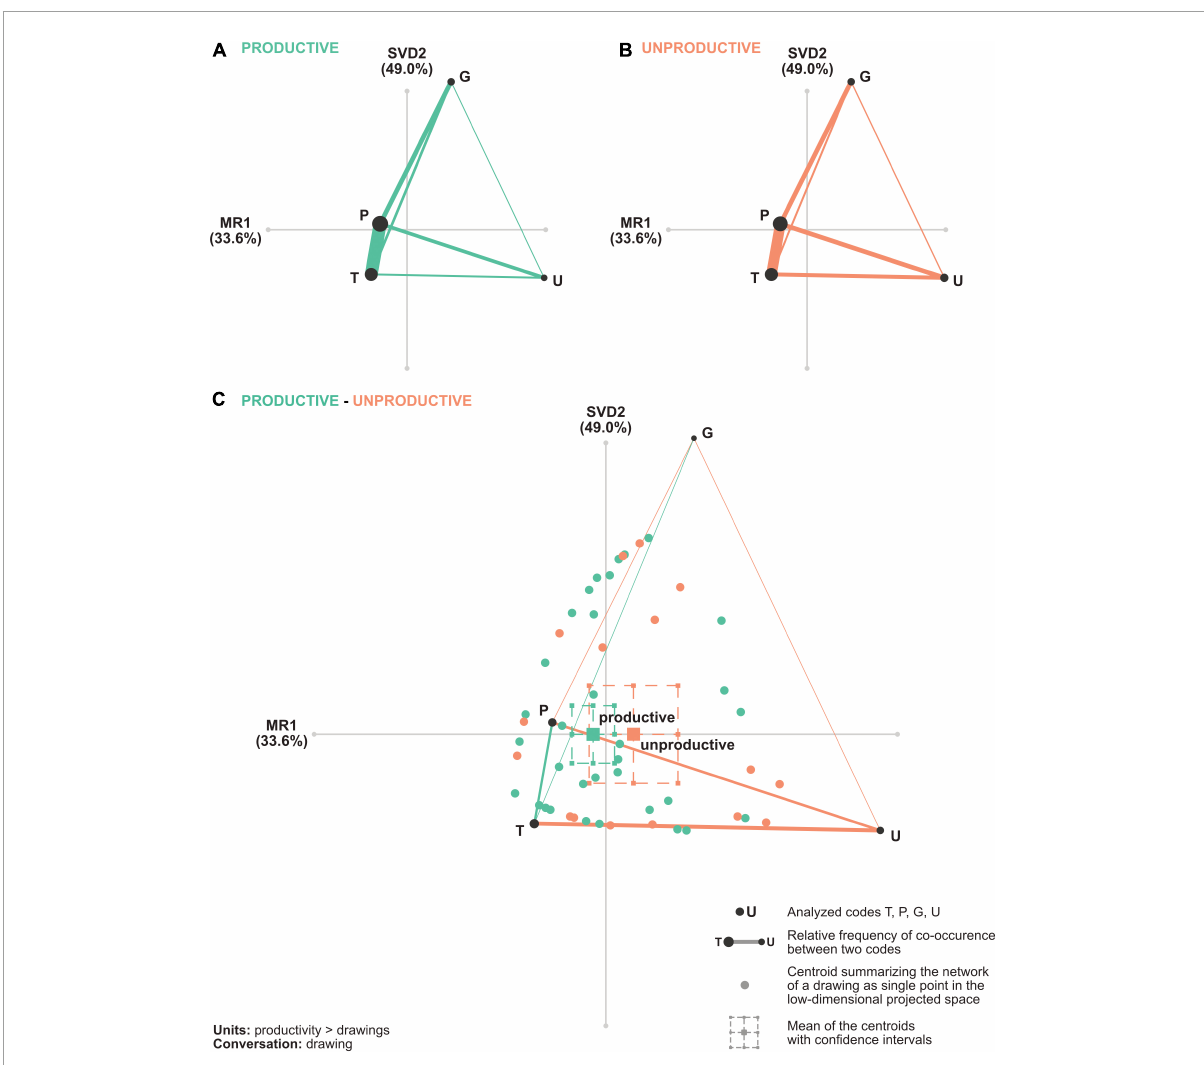
FIGURE6 Epistemic network for (A) productive drawings, (B) unproductive drawings, and (C) the subtracted epistemic network of productive and unproductive drawings using the collapsed AOI hit sequences during the construction process of every drawing ( N = 60). The drawing categories (T, target drawing; P, previous drawing; G, given information; U, unrelated drawings) serve as